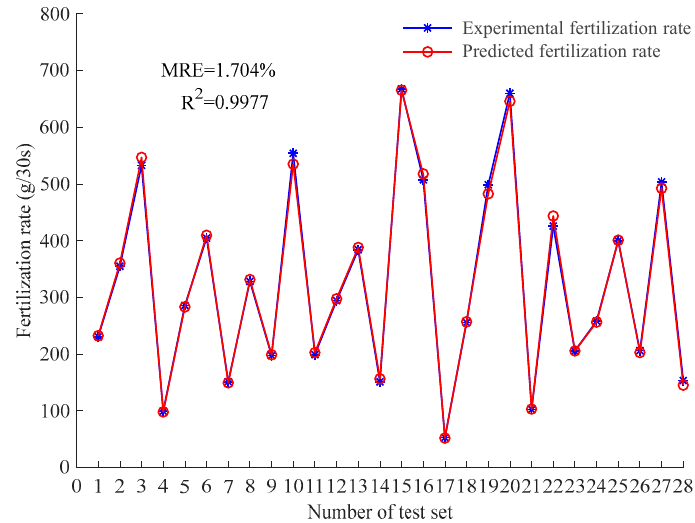
Figure 5. Comparison between test set data and bench test data.